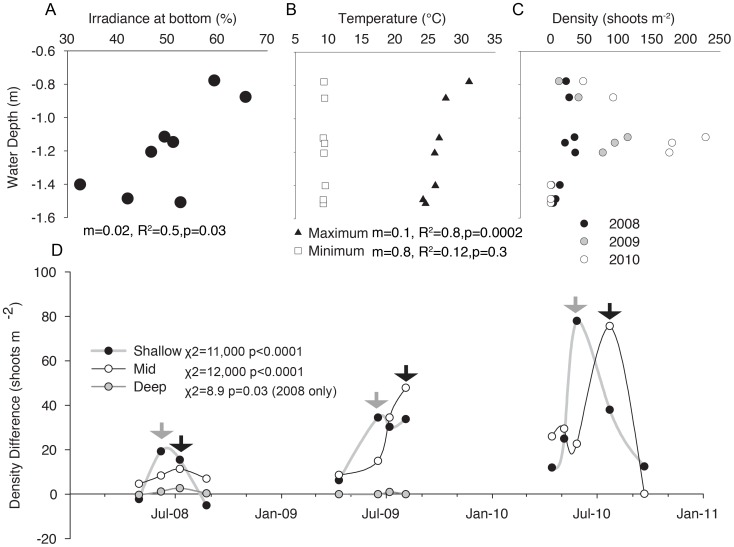
Experimental Zostera marina plots were planted in Hog Island Bay over a depth gradient of 0.8 m (range −0.78–1.5 MSL).Environmental conditions [light (A) and temperature (B)] varied with depth and resulted in differences in plant density (C). Plots at a depth less than 1 m and plots with a depth greater than 1.4 m had lower densities, while mid-depth plots had high densities that increased each year. Plots, replicated at each depth, were assigned to one of two levels of genetic diversity: relatively high (4.4 alleles per locus ±0.3 s.e.) and relatively low (3.5 alleles per locus ±0.3 s.e.). (D) Differences in density between the high diversity and low diversity plots were analyzed with a chi-square test (expected value of 0). Plants at the deepest depths died during the second growing season; therefore, differences were analyzed for the first year, while all plots had live plants, independently. Arrows indicate the timing of maximum density difference between high and low diversity plots.